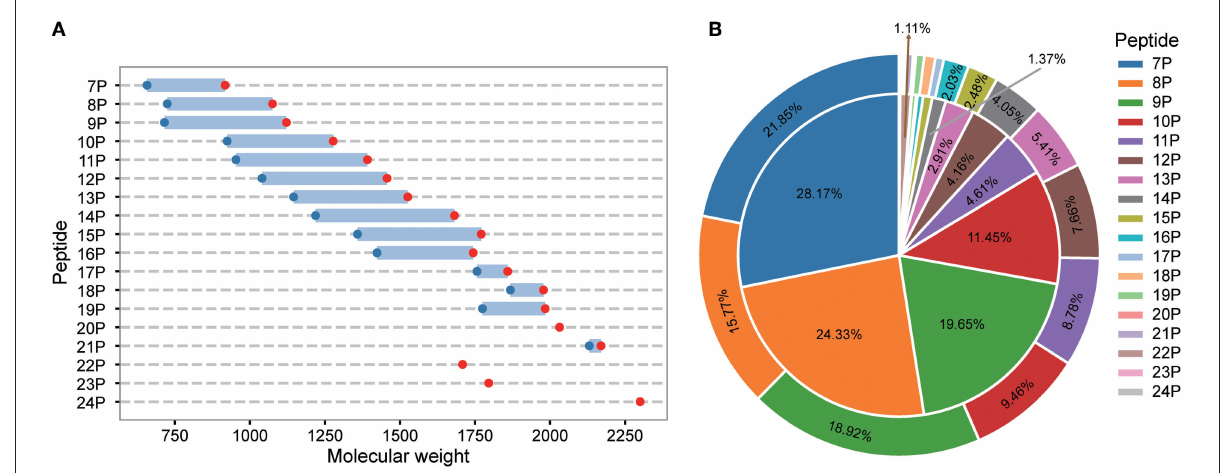
FIGURE1 Molecular weight (A) , MS area [ (B) , the inner layer], and number [ (B) , the outer layer] of peptides in the fermented mycelia of S. rugosoannulata . 7P-24P stands for heptapeptides-24 peptides. The unmarked proportion was part of the MS area, and the number was <